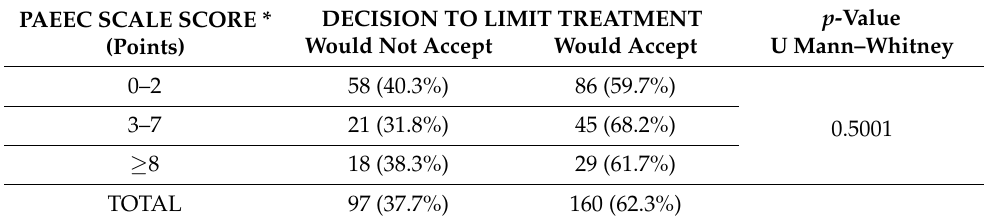
Table 6. Attitude toward treatment limitation according to quality of life prior to ICU admission.